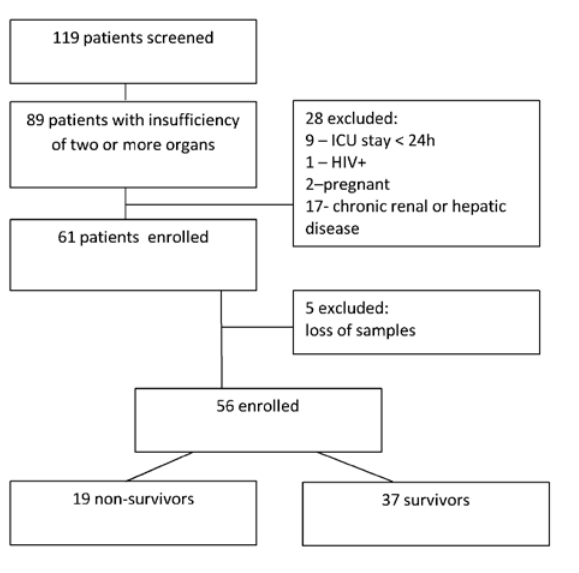
Figure 1: Flow chart of patients included in the